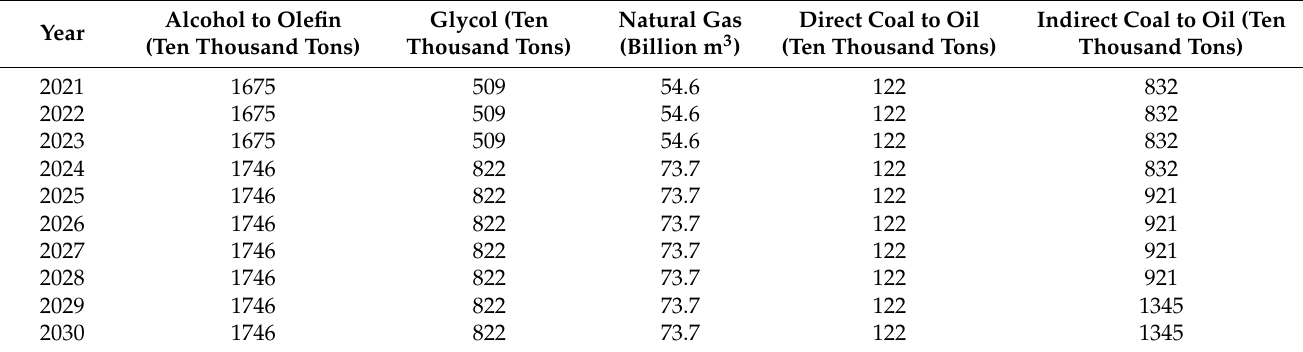
Table 5. Capacity forecast of the chemical industry.